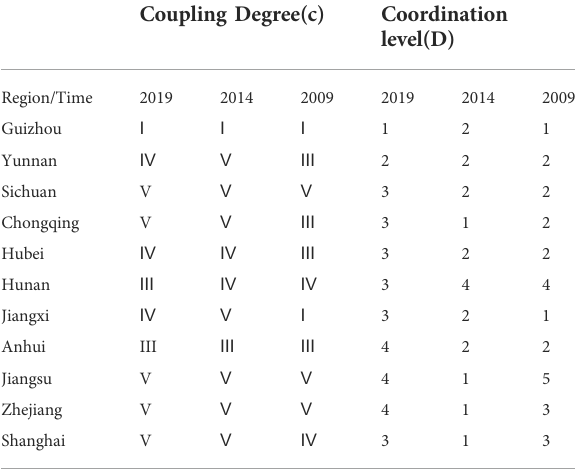
TABLE 7 The coupling of two-way FDI in eastern yangtze river economic belt.